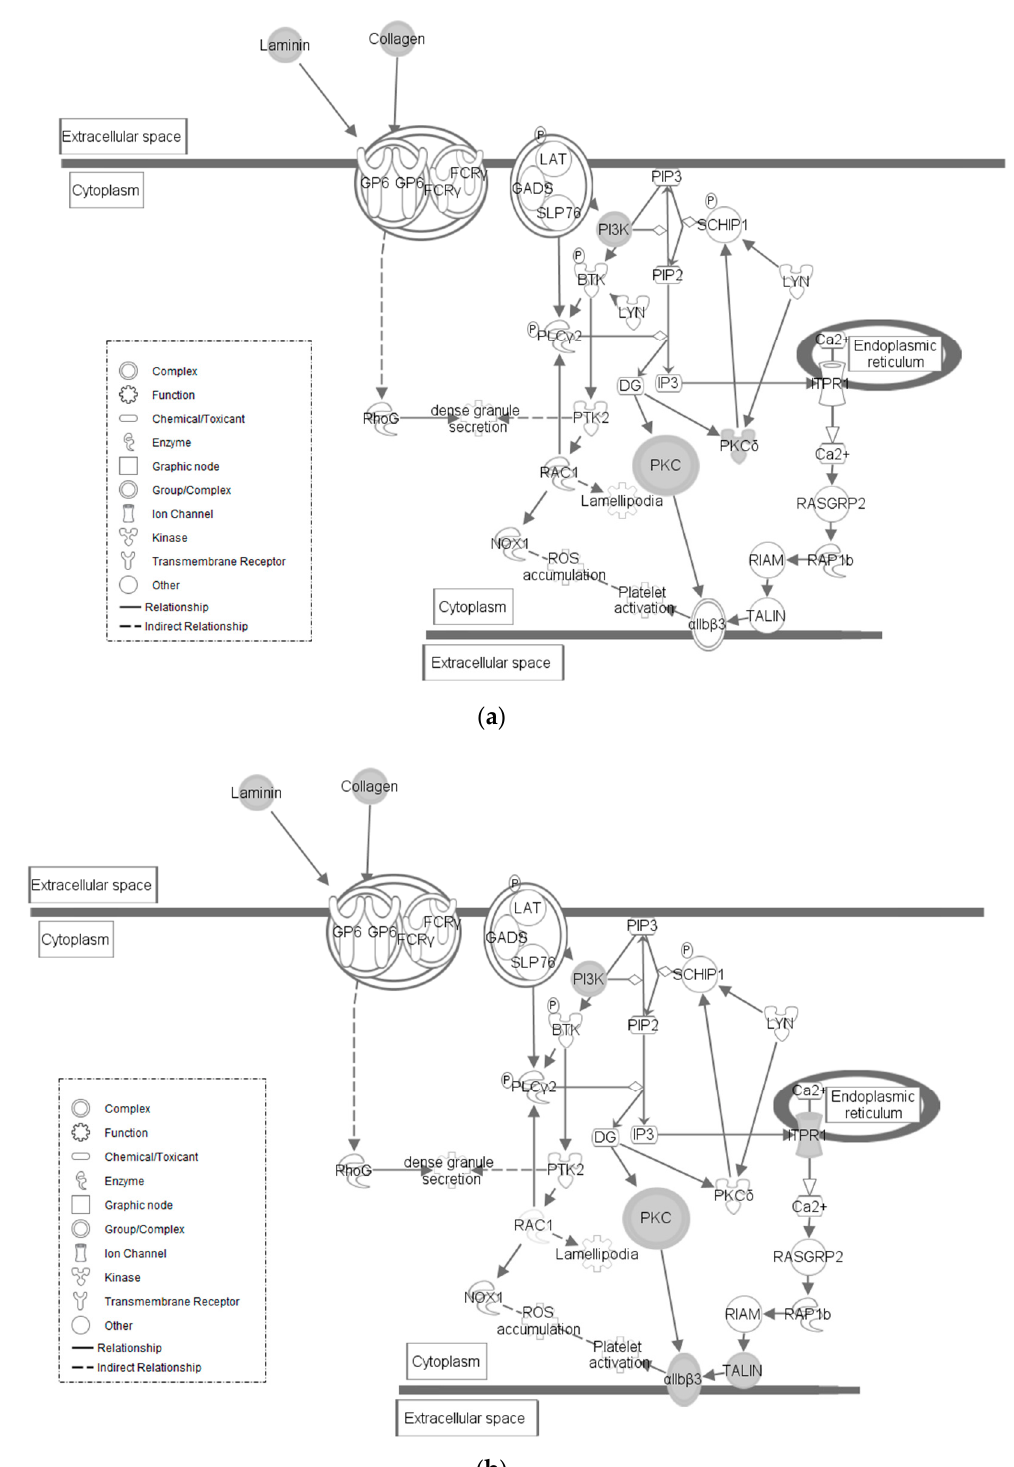
Figure 3. ( a ). GP6 Signaling Pathway in HS line of Japanese quail. Molecular interactions within the given pathway are shown. Grayed symbols indicate genes containing SNP mutations while white symbols indicate genes that do not contain SNPs but are functionally associated within the pathway. Each symbol represents the given molecule’s function. ( b ). GP6 Signaling in LS line of Japanese quail. Molecular interactions and symbols within the pathway are the same as described in Figure 3a.